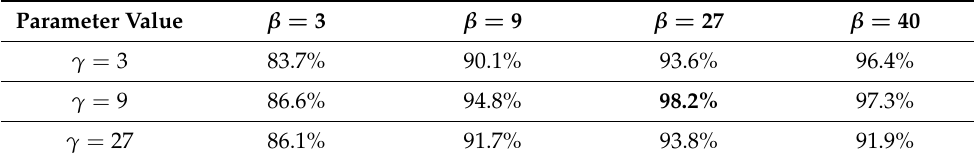
Table 5. Total accuracy for parameters corresponding to Table